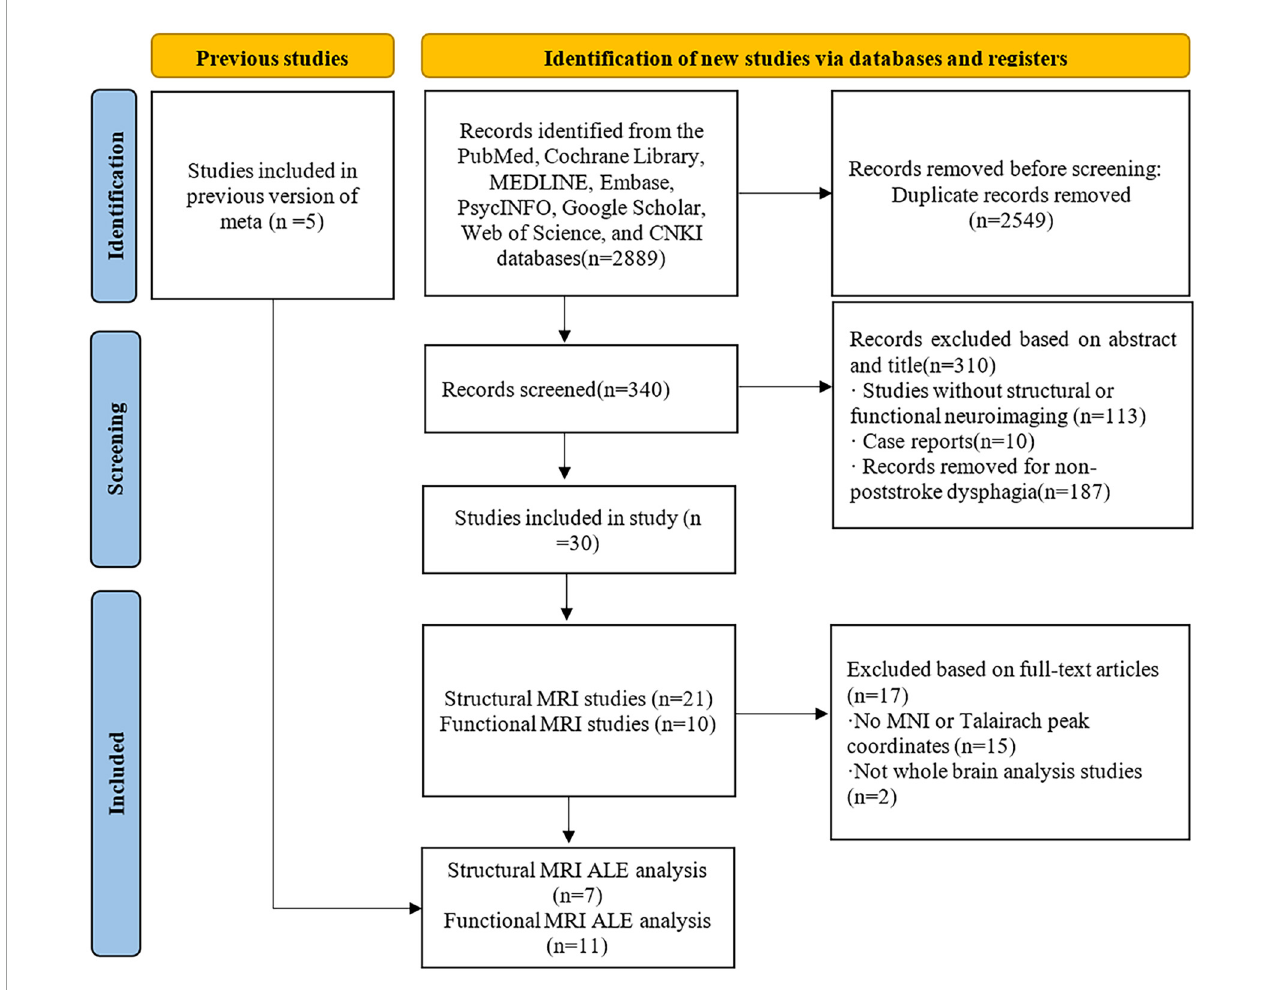
FIGURE1 Flow chart of Preferred Reporting Items for Systematic Reviews and Meta-Analyses (PRISMA) study selection